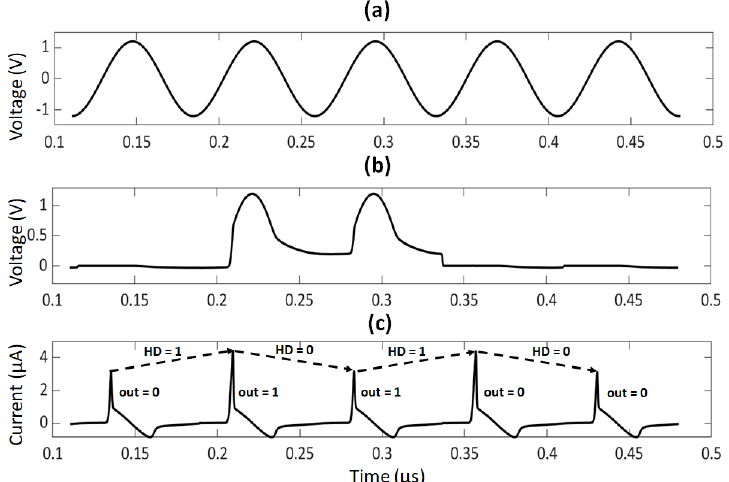
Figure 5. Use of Hamming distance as the power model for adiabatic ECRL circuits: ( a ) power-clock signal, ( b ) output voltage of the ECRL buffer, ( c ) current drawn from the supply by the buffer for output transitions 0 → 1 → 1 → 0 →